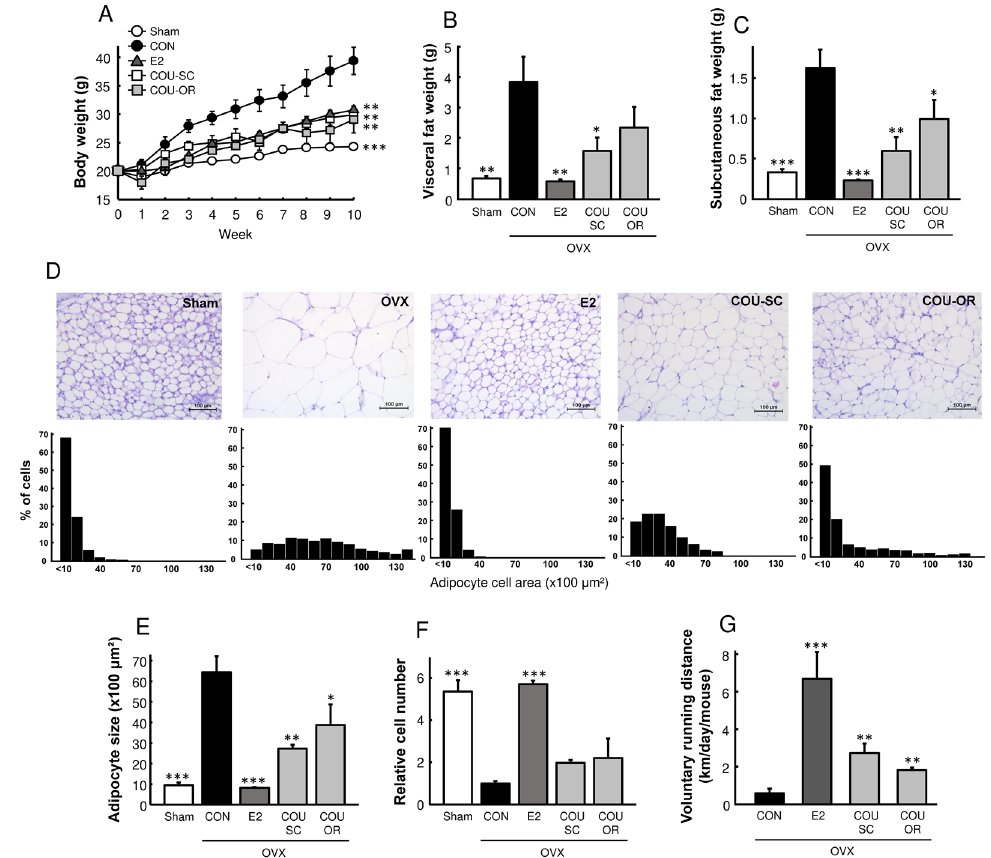
Figure 2. Preventive effects of coumestrol on adiposity in OVX mice fed a HFD. ( A ) Body weight and weights of ( B ) visceral and ( C ) subcutaneous adipose depots. ( D ) Representative H&E-stained section of parametrial adipose tissue and distribution histogram of adipocyte size (scale bar = 100 µ m). ( E ) Average size of adipocytes and ( F ) relative adipocyte number. ( G ) At 6 weeks after surgery, all OVX mice were housed singly with running wheels, and voluntary running distance was recorded. Values represent means ± SEM ( n = 7 for ( A – C ), n = 4 for ( D – G )). CON, control; E2, 17 β -estradiol; COU-SC, coumestrol subcutaneous treatment; COU-OR, coumestrol oral treatment; OVX, ovariectomized. * Significantly different from the OVX control group (* p < 0.05, ** p < 0.01, *** p < 0.001).